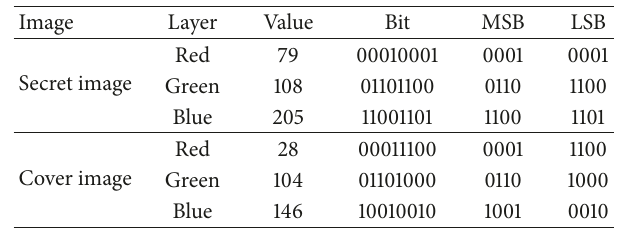
Table 2: Example